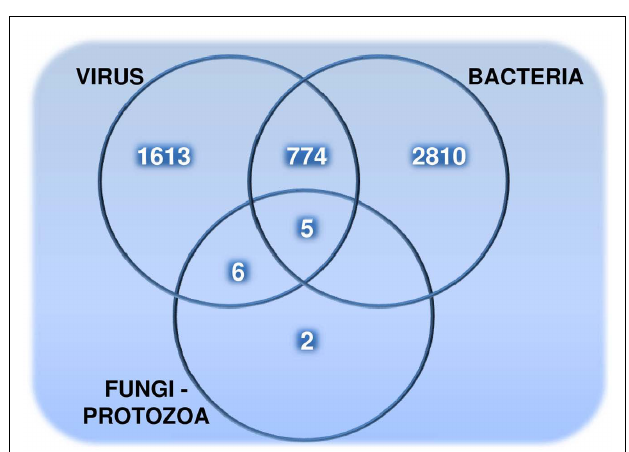
FIGURE 1 |The number of pathogen-targeted human proteins that are grouped based on their interactions with viruses, bacteria, and fungi – protozoa (targeted by fungi and/or